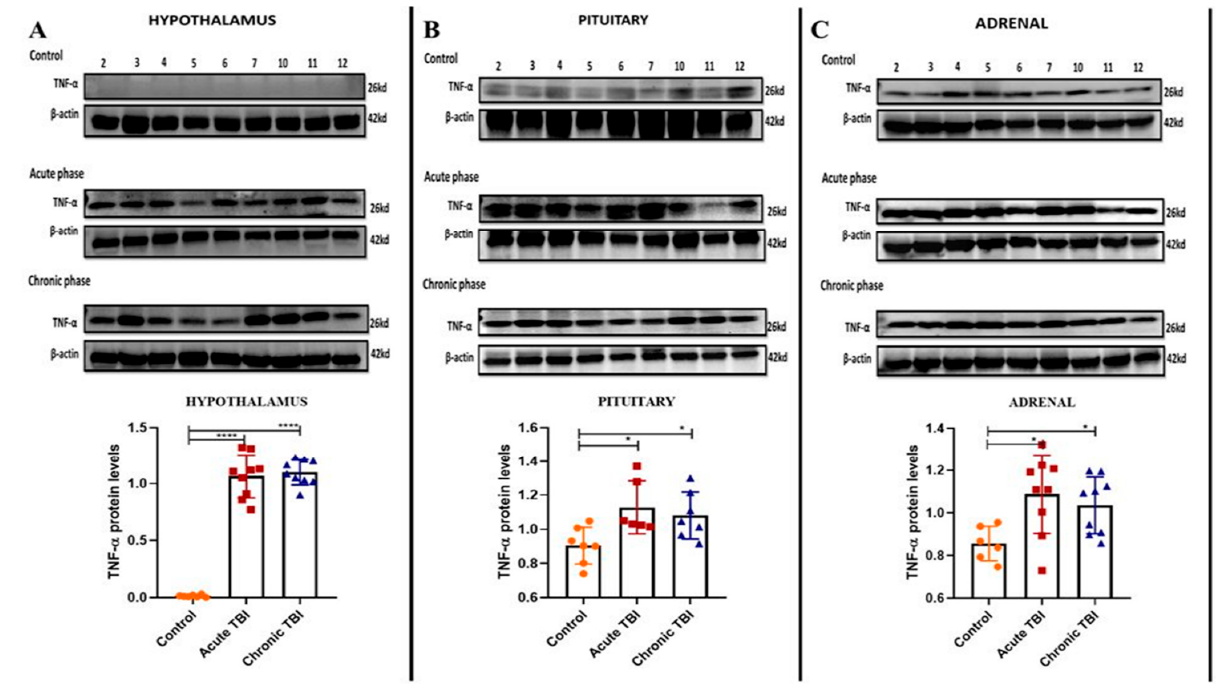
Figure 1. Western blot images and bar graphs of Tnf- α levels in the acute and chronic phase after TBI in the hypothalamus, pituitary, and adrenals. ( A ) Tnf- α protein levels in the hypothalamus after TBI in the acute, chronic and control groups. ( B ) Tnf- α protein levels in the pituitary after TBI in the acute, chronic and control groups. ( C ) Tnf- α levels in the adrenals after TBI in the acute, chronic and control groups. β -Actin was used as a loading control. Data are presented as mean ± SD (n = 9 rats in each group). (* p < 0.05, **** p < 0.0001). All experiments were independently repeated at least twice.